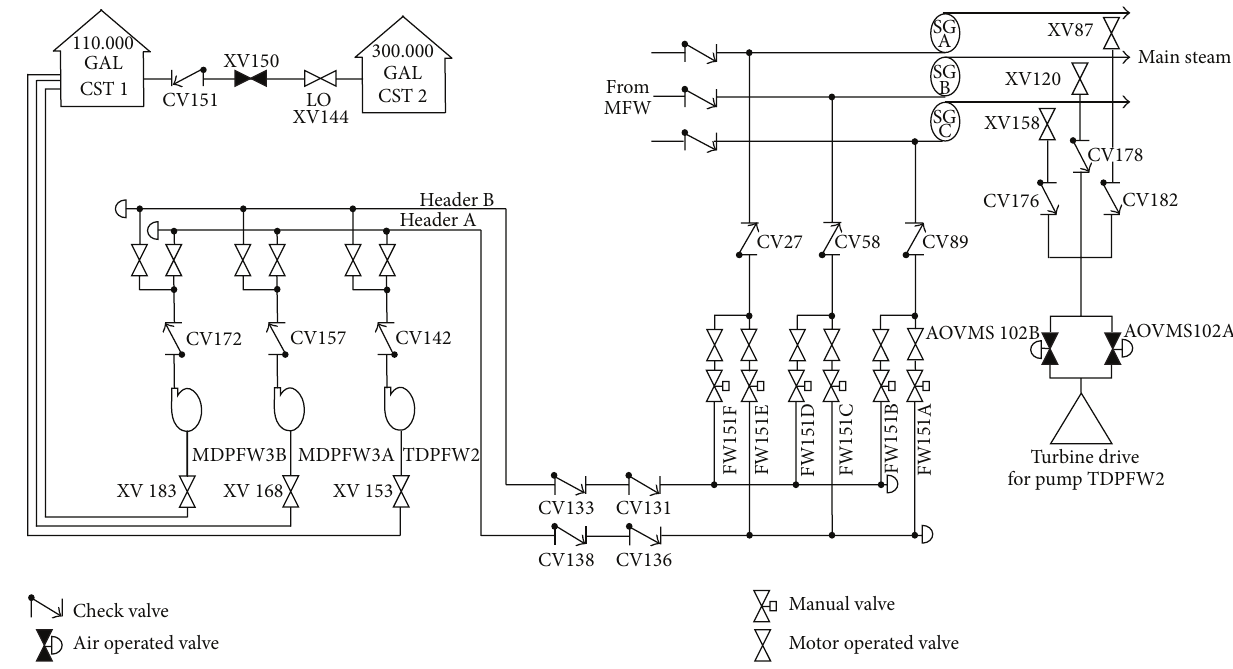
Figure 2: AFW system simplified